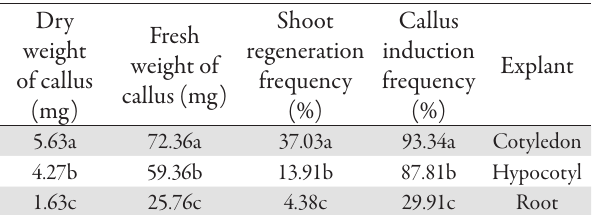
Tab. 2. Means comparison of different explants of Foeniculum vulgare under salinity stress Dry weight of callus